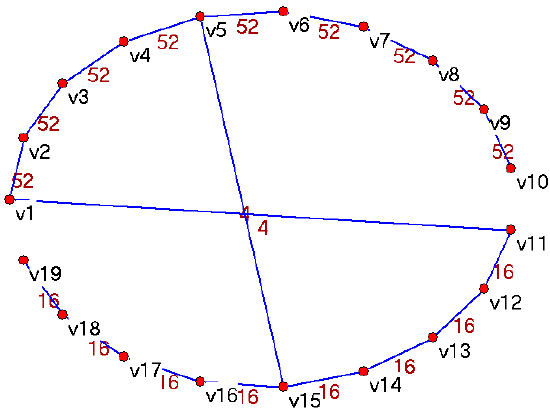
Figure 3. SCSG graph with CHAIN connectivity for the 19 files described in Table